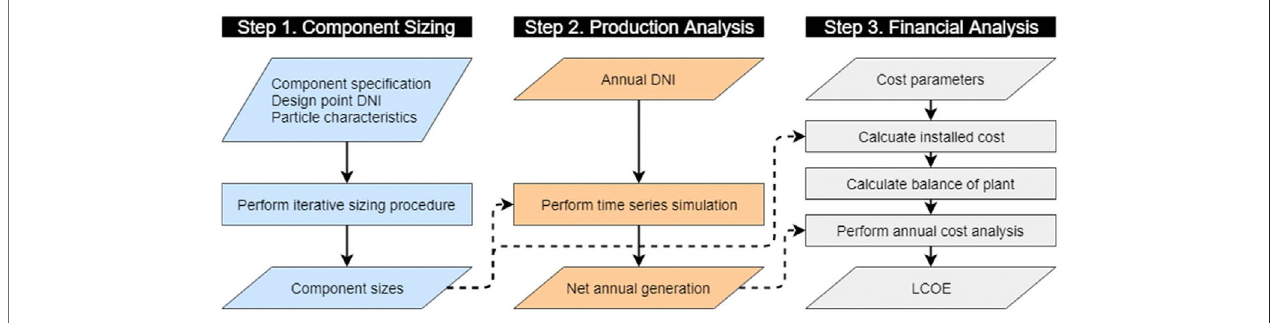
FIGURE 2 | High-level procedural summary for technoeconomic analyses.